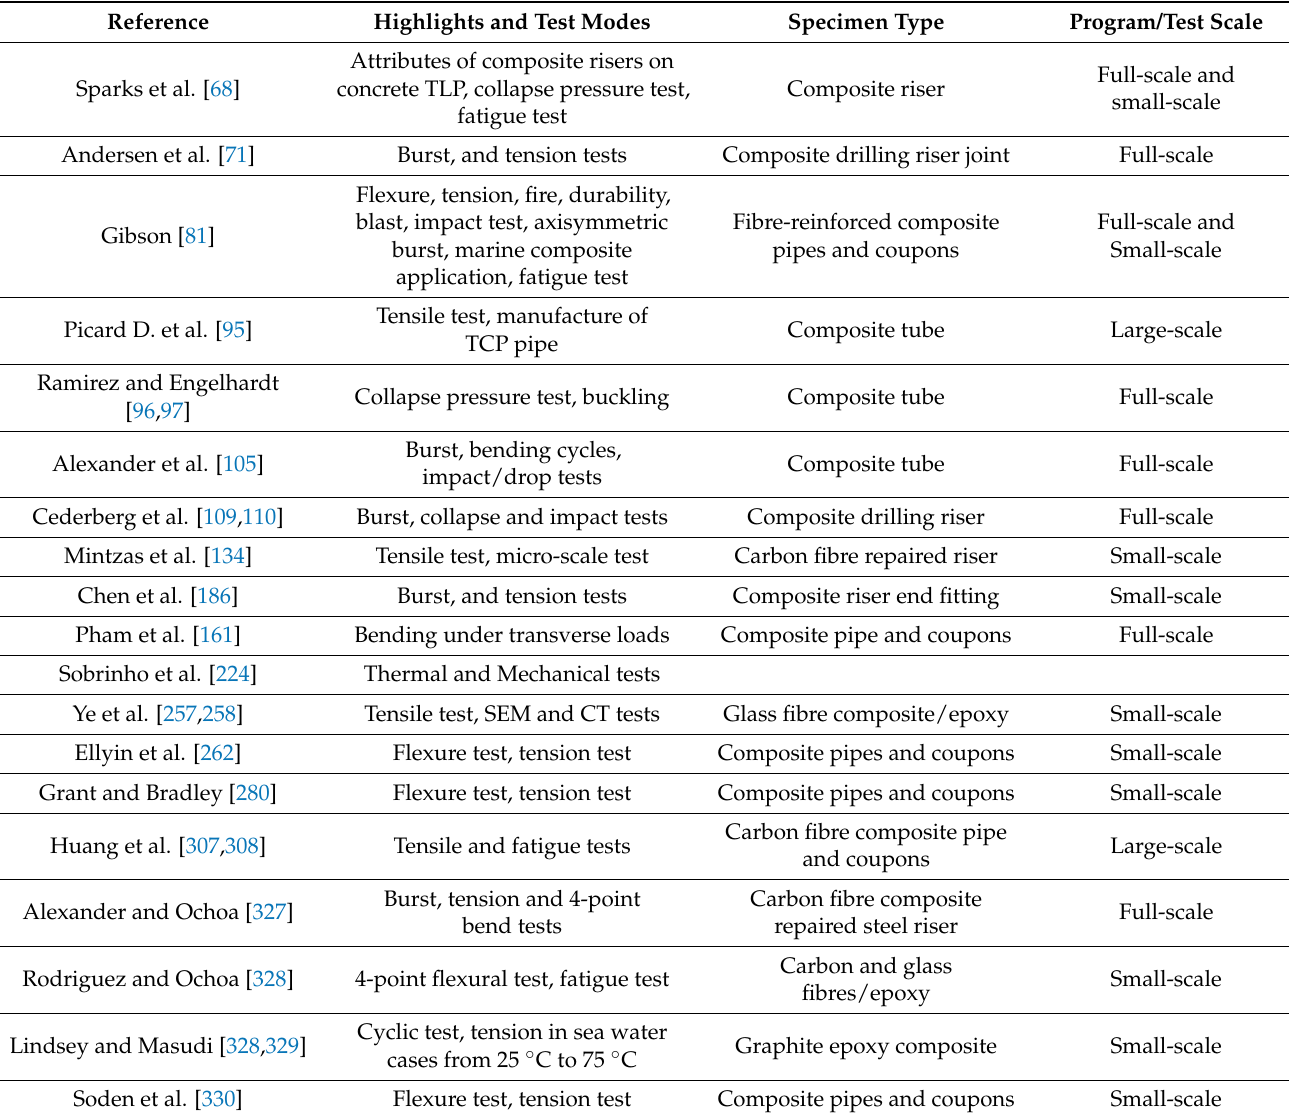
Table 6. Experimental tests on composite risers with the scale of the